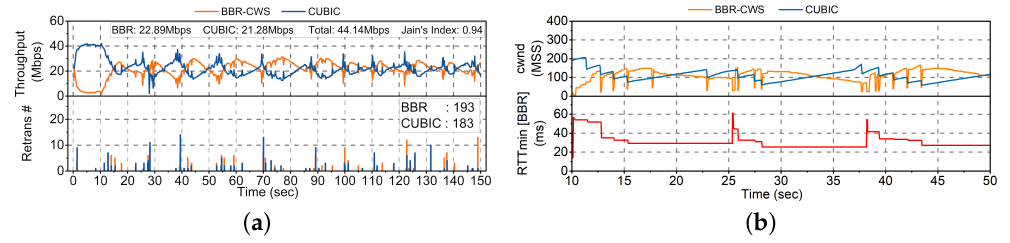
Figure 12. BBR-CWS vs. CUBIC (deep buffer: 5 BDP): ( a ) throughput and retransmission; and ( b ) cwnd and RTprop of